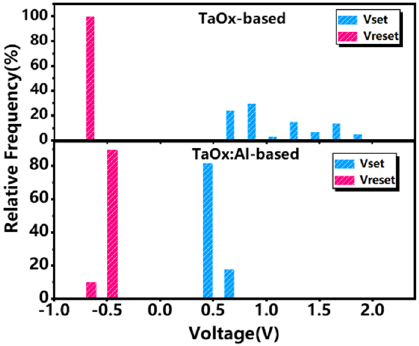
Figure 3. Cycle to cycle distributions of set/reset voltage of the undoped ( top ) and locally doped devices ( bottom ).